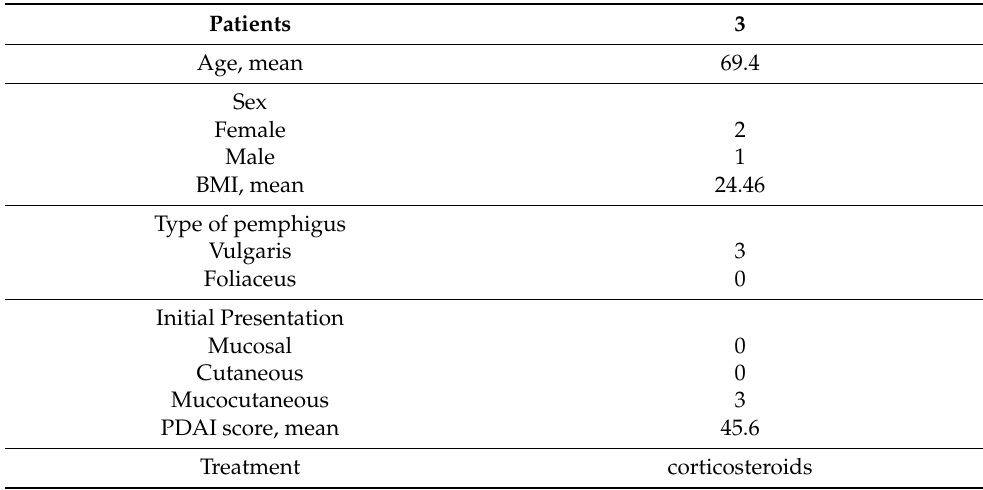
Table 1. Baseline characteristics of patients with pemphigus treated with